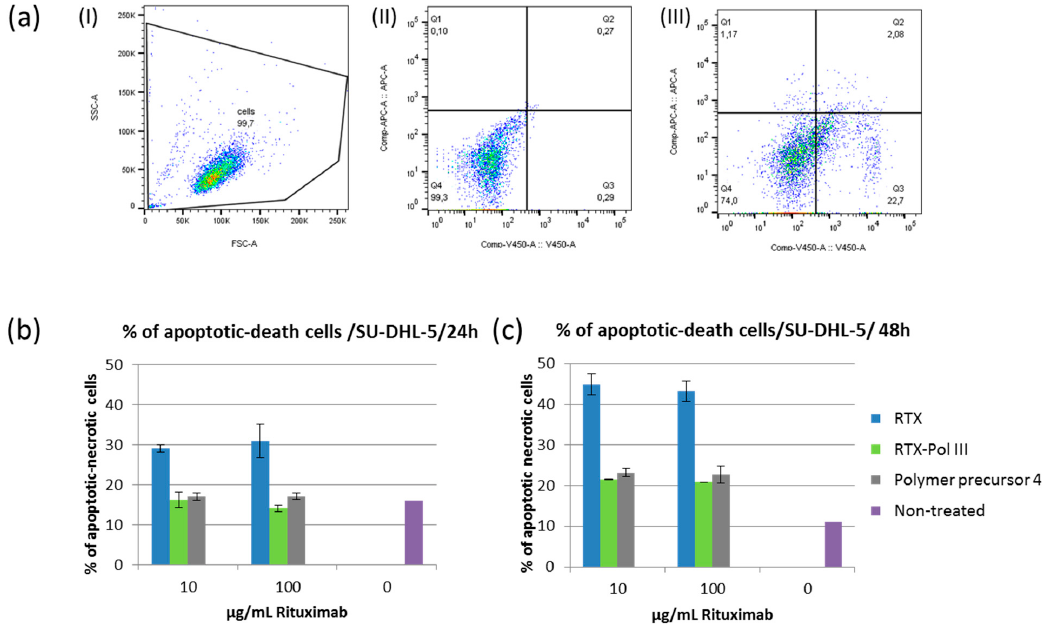
Figure 5. Percentage of apoptotic or dead cells after incubation with RTX, RTX-Pol III or polymer precursor 4 ; ( a ) gating strategy used for analysis: (I) cell population, (II) non-treated cells, (III) RTX-treated cells (quadrants were based on the intensity of annexin-APC and Sytox Blue-V450); ( b ) cell death changes after 24 h of incubation; ( c ) cell death changes after 48 h of incubation.